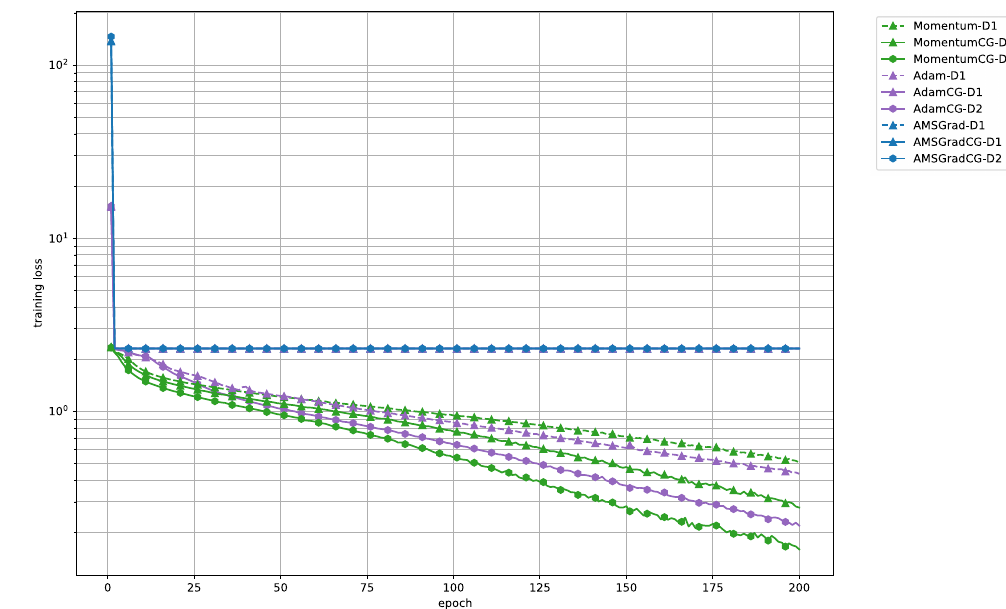
Figure 4. Loss function value versus number of epochs on the CIFAR-10 dataset for training (diminishing).